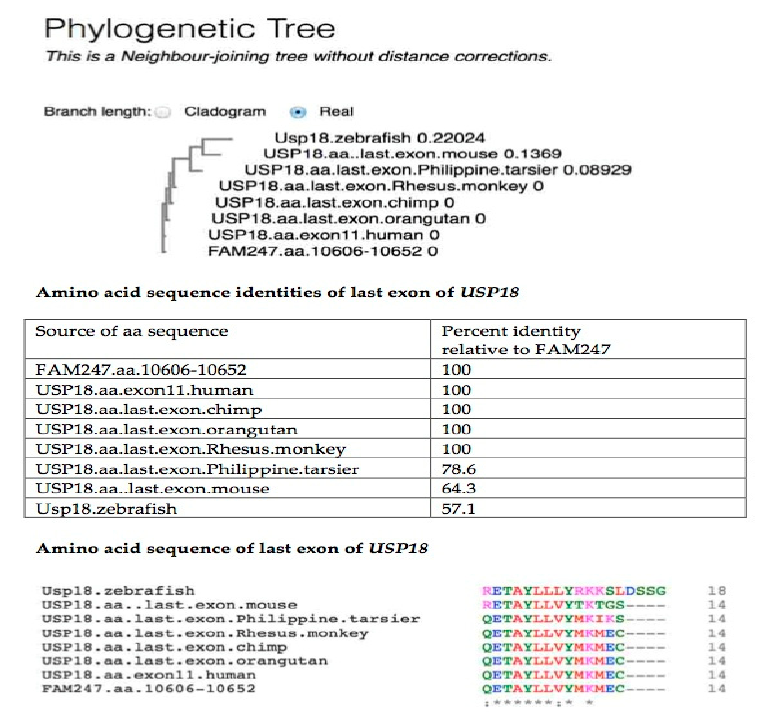
Figure 5. Alignment of the USP18 terminal exon amino acid sequences from seven species compared with the FAM247 translated amino acid sequence. Data were obtained using the EBI Clustal Omega sequence alignment and phylogeny programs. The EMBL-EBI Clustal Omega Multiple Sequence Alignment program [19] at website http: // www.ebi.ac.uk / Tools / msa / clustalo / was used for aa sequence alignment. ( Top ) Phylogenetic tree of USP18 terminal exon aa sequences from seven species and the FAM247 aa sequence. ( Middle ) The percent identities were created using Clustal 2.1. ( Bottom ) Alignment of aa